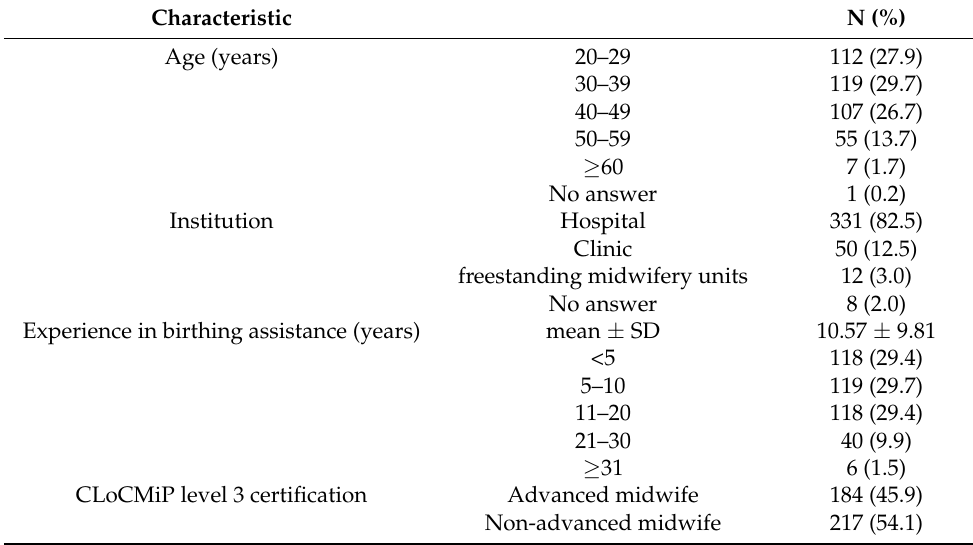
Table 1. Characteristics of the survey respondents (N =